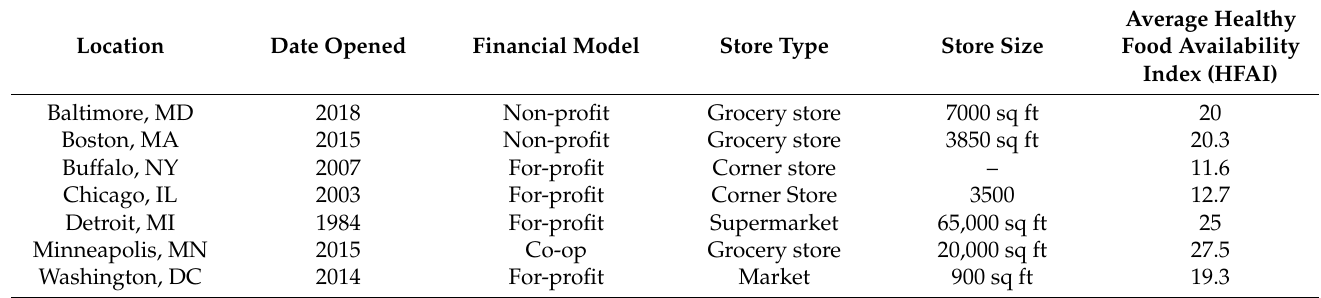
Table 1. Summary of the healthy community store case studies: store characteristics.